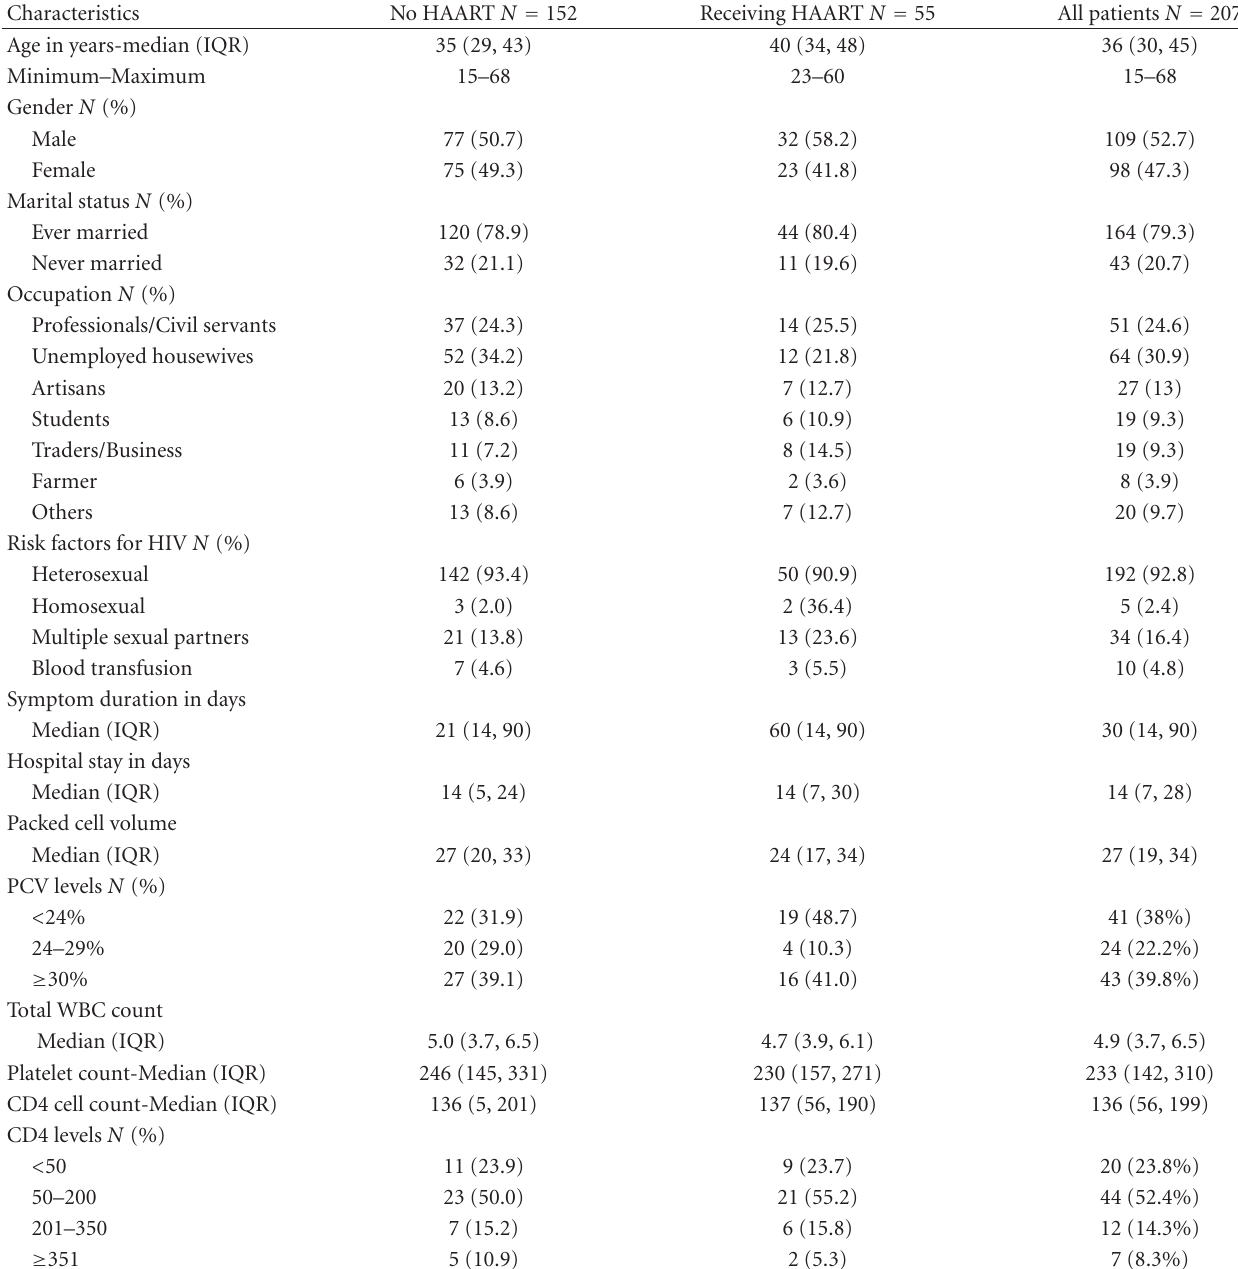
Table 1: Baseline characteristics of hospitalised HIV/AIDS patients in relation to antiretroviral therapy status.